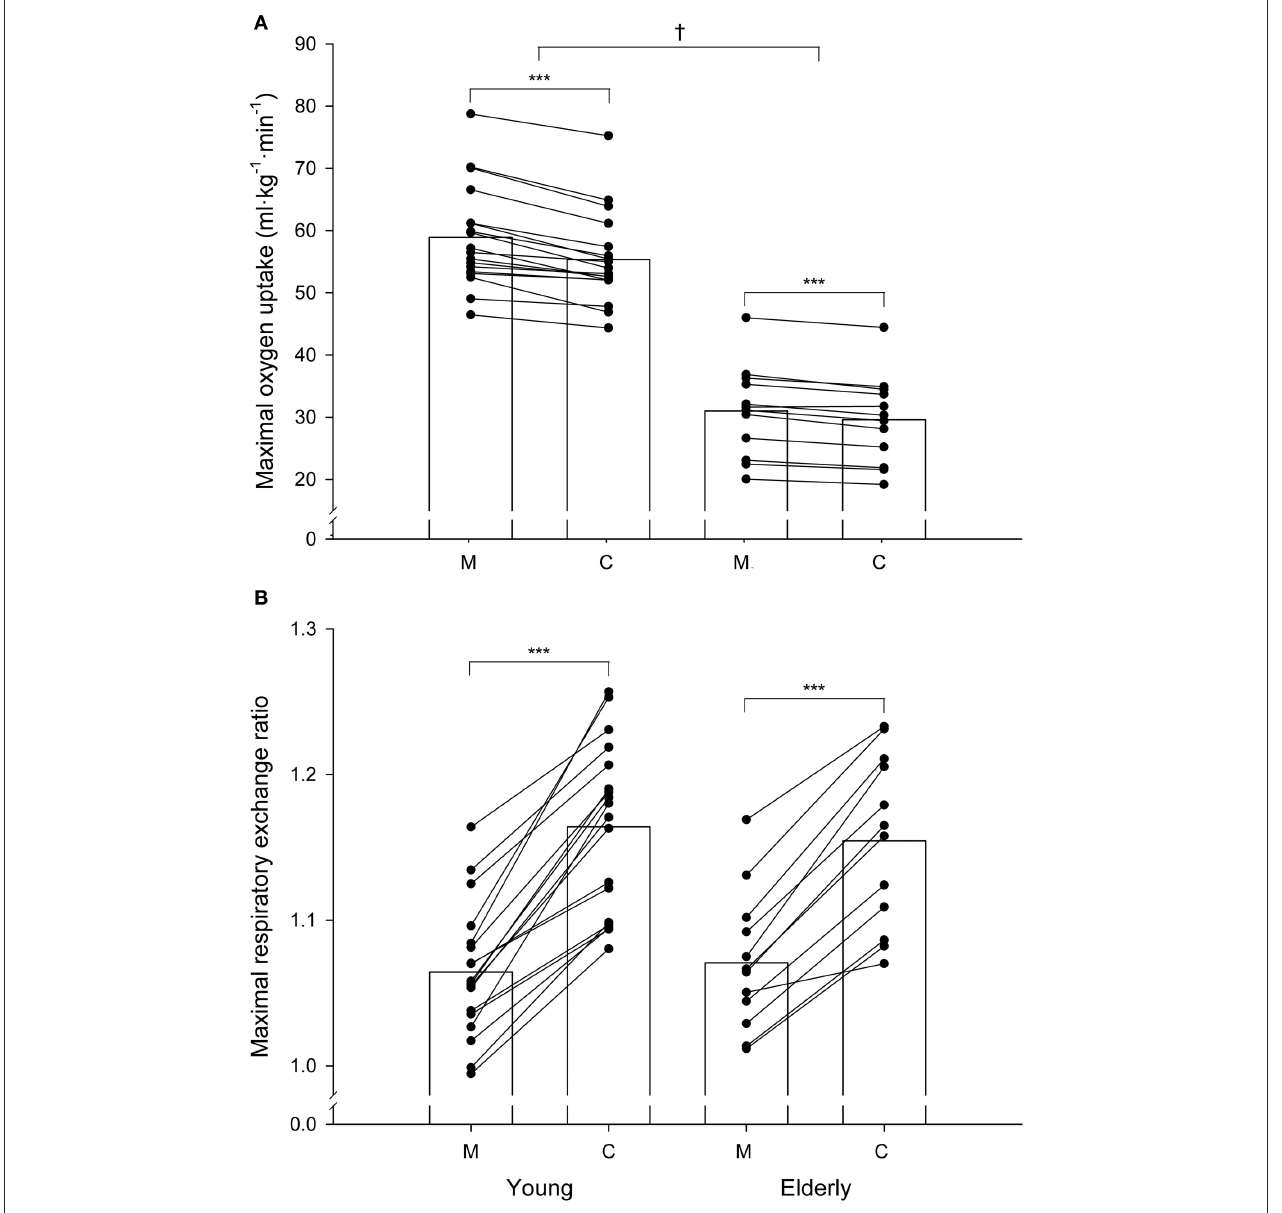
FIGURE 3 | Individual measured (M) and corrected (C) values of maximal oxygen uptake (A) and maximal respiratory exchange ratio (B) in the young and elderly groups. Maximal oxygen uptake is expressed in ml · kg · min − 1 . The bars indicate mean values. *** Significant difference between the corrected and the corresponding measured values ( P < 0.001 ). † Significant difference between groups ( P < 0.05